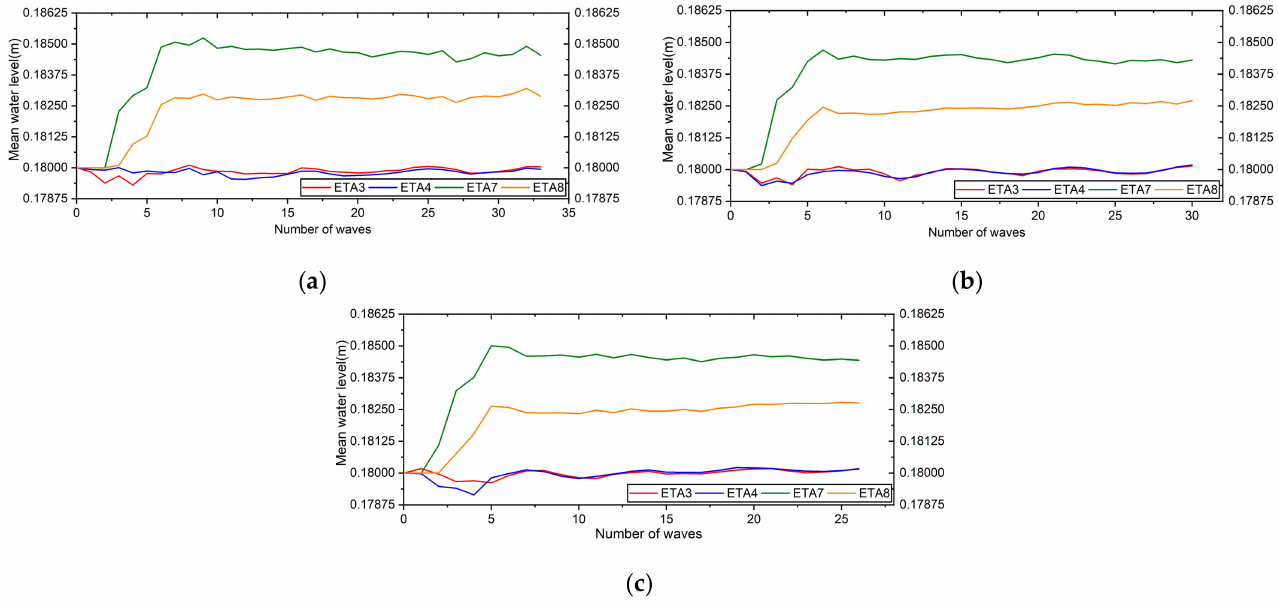
Figure 11. Variation in mean water levels per wave for cross-section 1 at radial distances of 300 cm (Eta 3), 336 cm (Eta 4), 426 cm (Eta 7), and 432 cm (Eta 8) in ( a ) case 1 (T-1.80 s), ( b ) case 2 (T-2.0 s), and ( c ) case 3 (T-2.25 s).